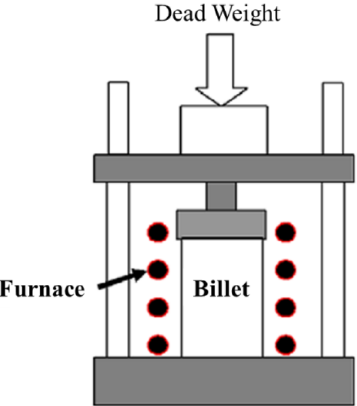
Figure 6. Scheme of parallel plate deformation set up